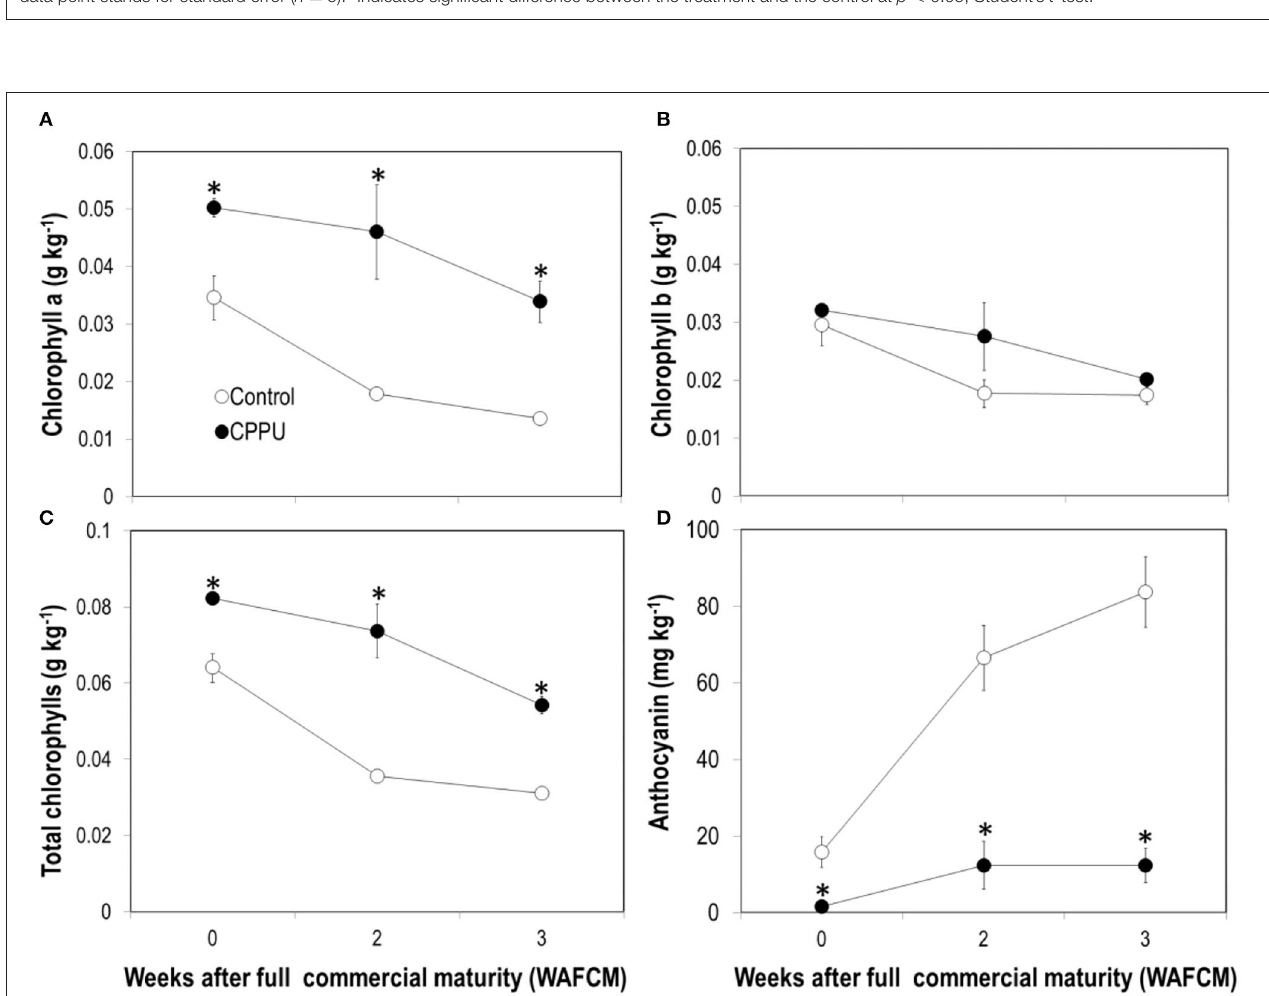
FIGURE 2 | Effect of CPPU treatment on the weights of the fruit (A) , aril (B) , and pericarp (C) . Shaded bar indicates commercial harvesting period; vertical bar at each data point stands for standard error ( n = 5). *Indicates significant difference between the treatment and the control at p < 0.05, Student’s t -test.